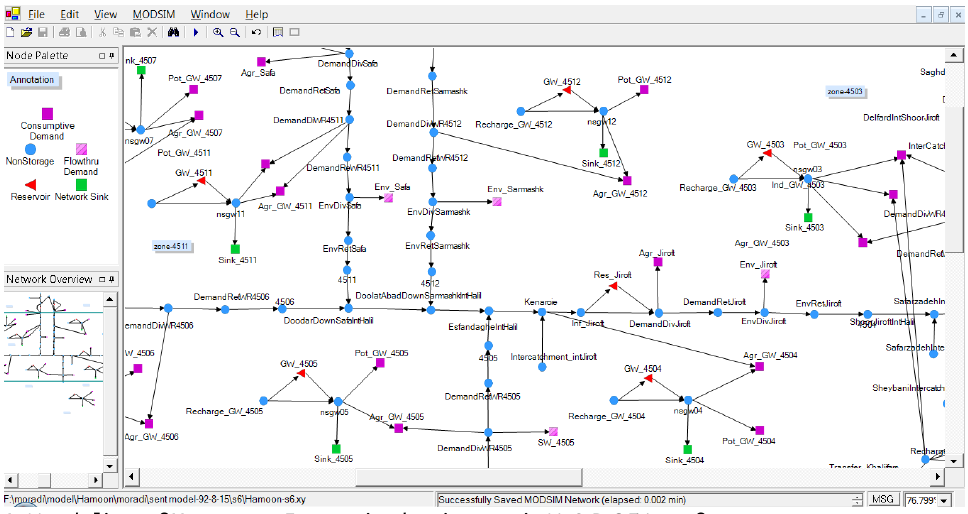
Figure 4. Modeling of Hamoon- Jazmorian basin area in MODSIM